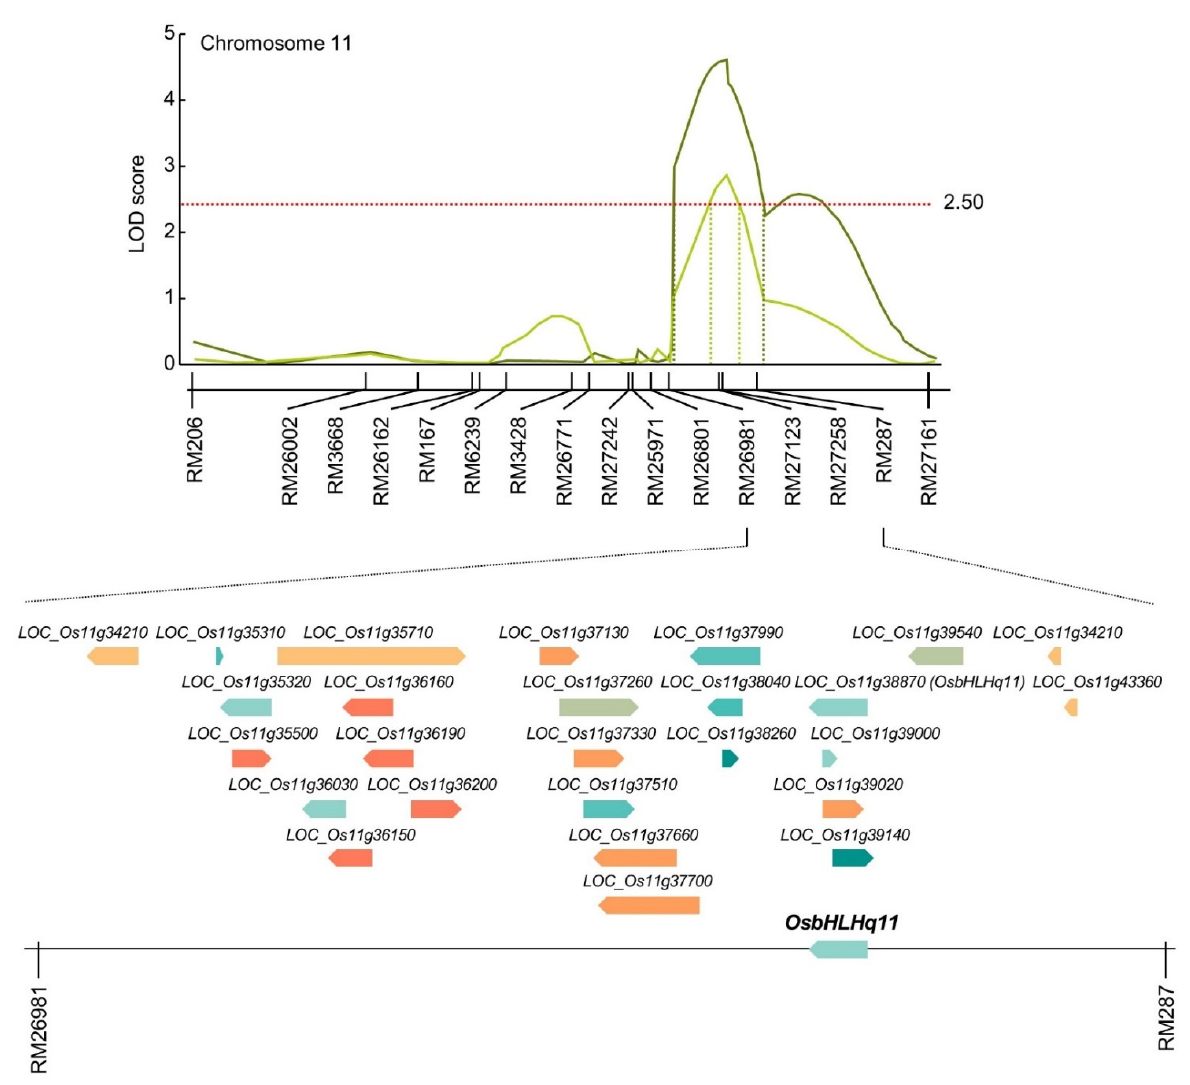
Figure 4. Physical map related to chlorophyll content in rice. In the RM26981-RM287 region on chromosome 11, 2 QTLs associated with chlorophyll content were detected. OsbHLHq11 is a basic helix-loop-helix transcription factor that can inhibit seed germination, chlorophyll accumulation, and assembly of photosynthetic complexes, and plays important roles in plant growth, development, light signaling, and stress response.